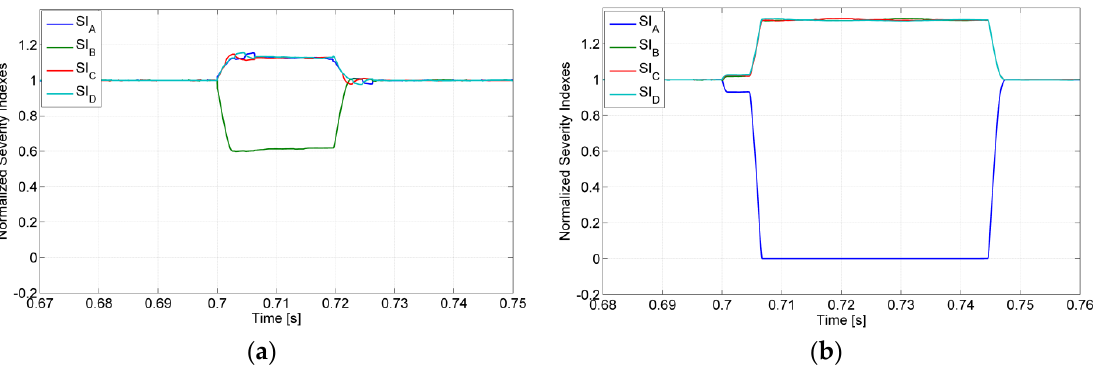
Figure 13. Results of the four normalized indexes ( a ) for an open-switch fault in the semiconductor S 12 ; ( b ) for an open-switch fault in the semiconductor S 21 .